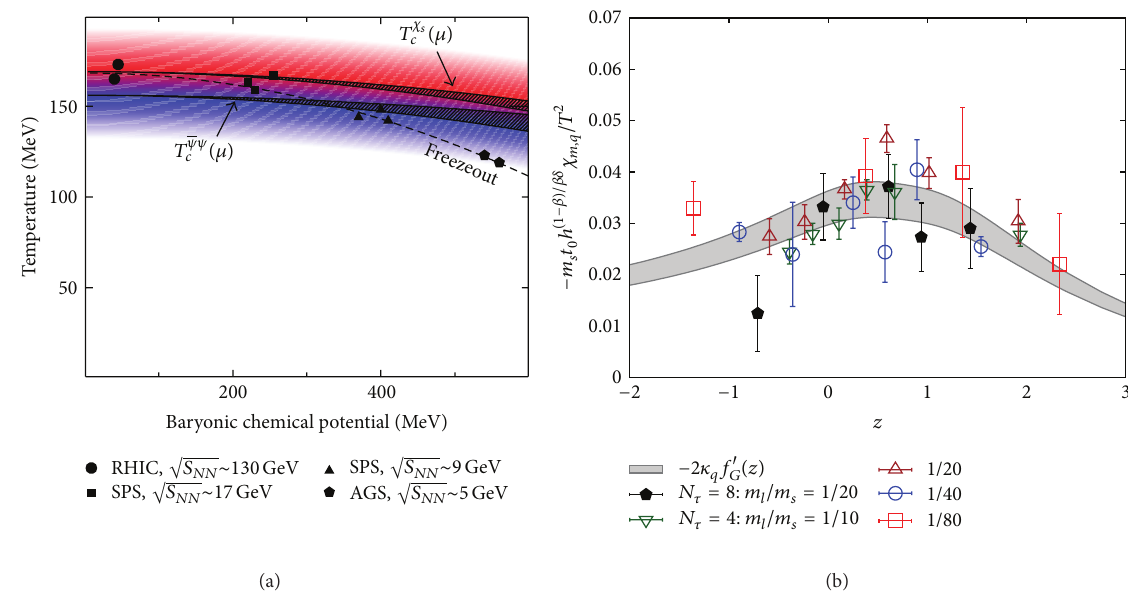
Figure 17: In (a), the width of the pseudocritical region for chiral condensate is shown as a blue curve and that for strange quark susceptibility is shown as a red curve, from [143]. In (b), the scaling of the mixed susceptibility is shown for different light quark masses and at the physical value of strange quark mass, from